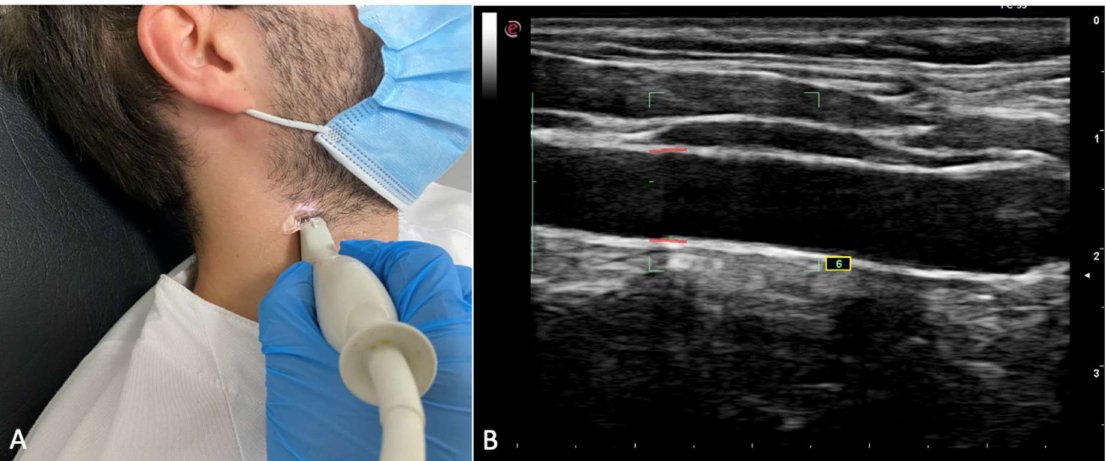
Figure 1. Figure showing ultrasonographic intima-media thickness (IMT) assessment. ( A ) Position of the patient and US probe. ( B ) Image showing common carotid artery. Once the common carotid artery is detected, IMT is